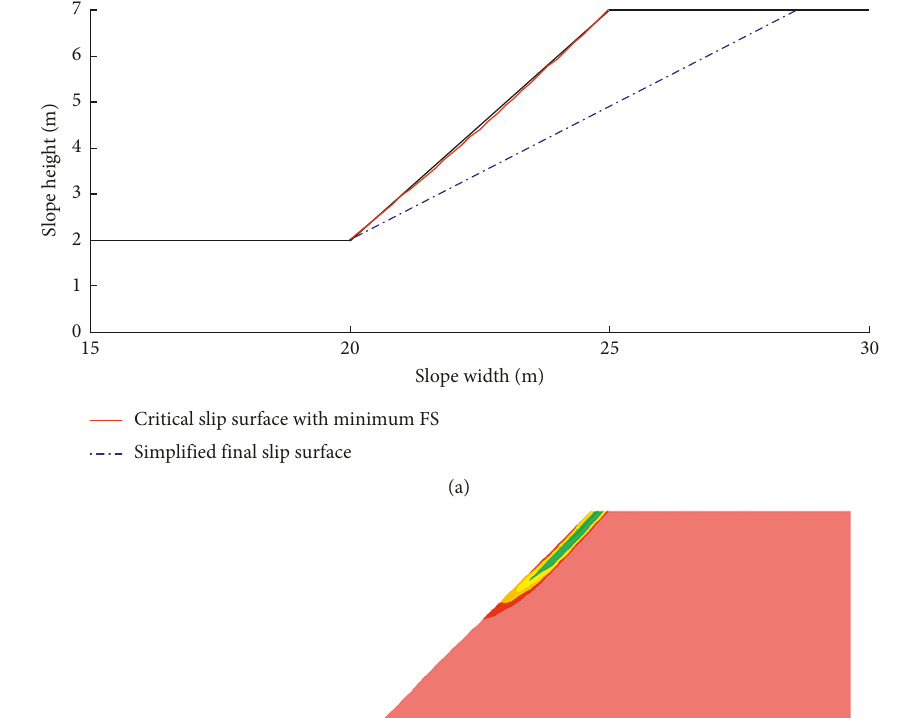
Figure 1: Summary of calculation results for homogeneous slope. (a) Critical slip surface obtained by LEM (the minimum FS Contour of shear strain rate obtained by FDM (with the minimum FS surface after